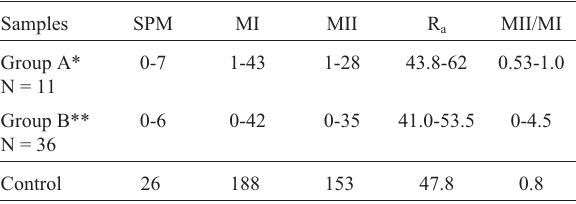
Table 2 - Germ cell cytogenetic analysis in the 47 infertile men with meiotic activity and in a normal control. Samples